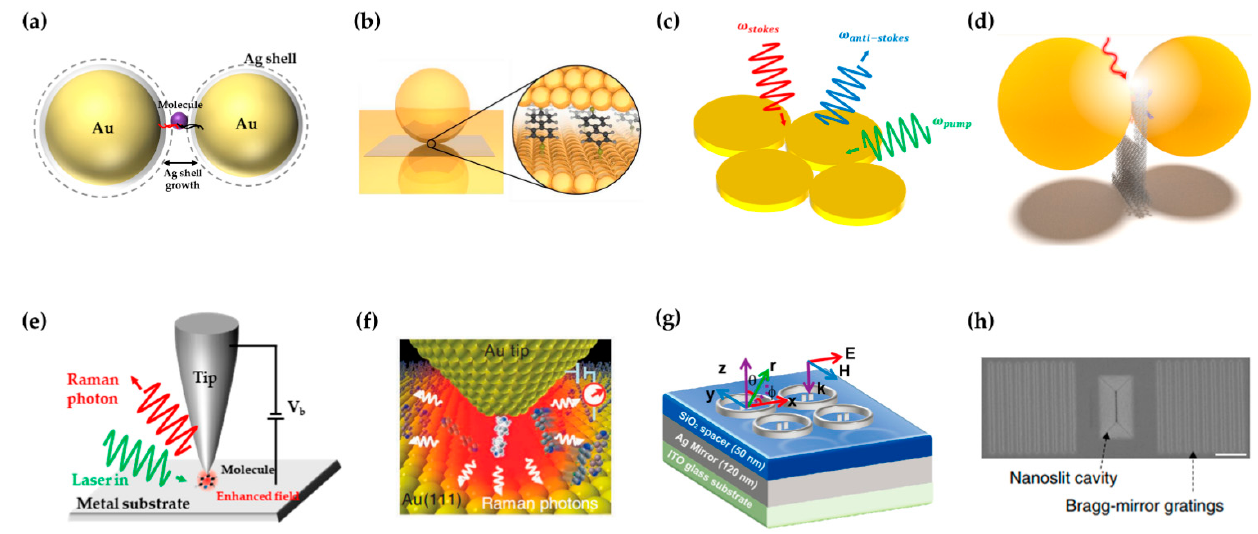
Figure 2. High-reproducibility substrates for SM-SERS. ( a ) Nanogap-engineered SERS-active GSND. ( b ) NPoM configuration. Figure reproduced from [46]. ( c ) The enhancement map of the quadrumer substrate. ( d ) Nanoparticle dimer assembled on the DNA origami nanofork. Figure reproduced from [57]. ( e ) Tunneling-controlled TERS. ( f ) Schematic diagram of FM-TERS. Figure reproduced from [64]. ( g ) Nanoantenna chip for SM-SERS. Figure reproduced from [66]. ( h ) The SEM image of the nanoslit device. Scale bar, 1 μ m. Scanning electron microscopy, SEM. Figure reproduced from [15].